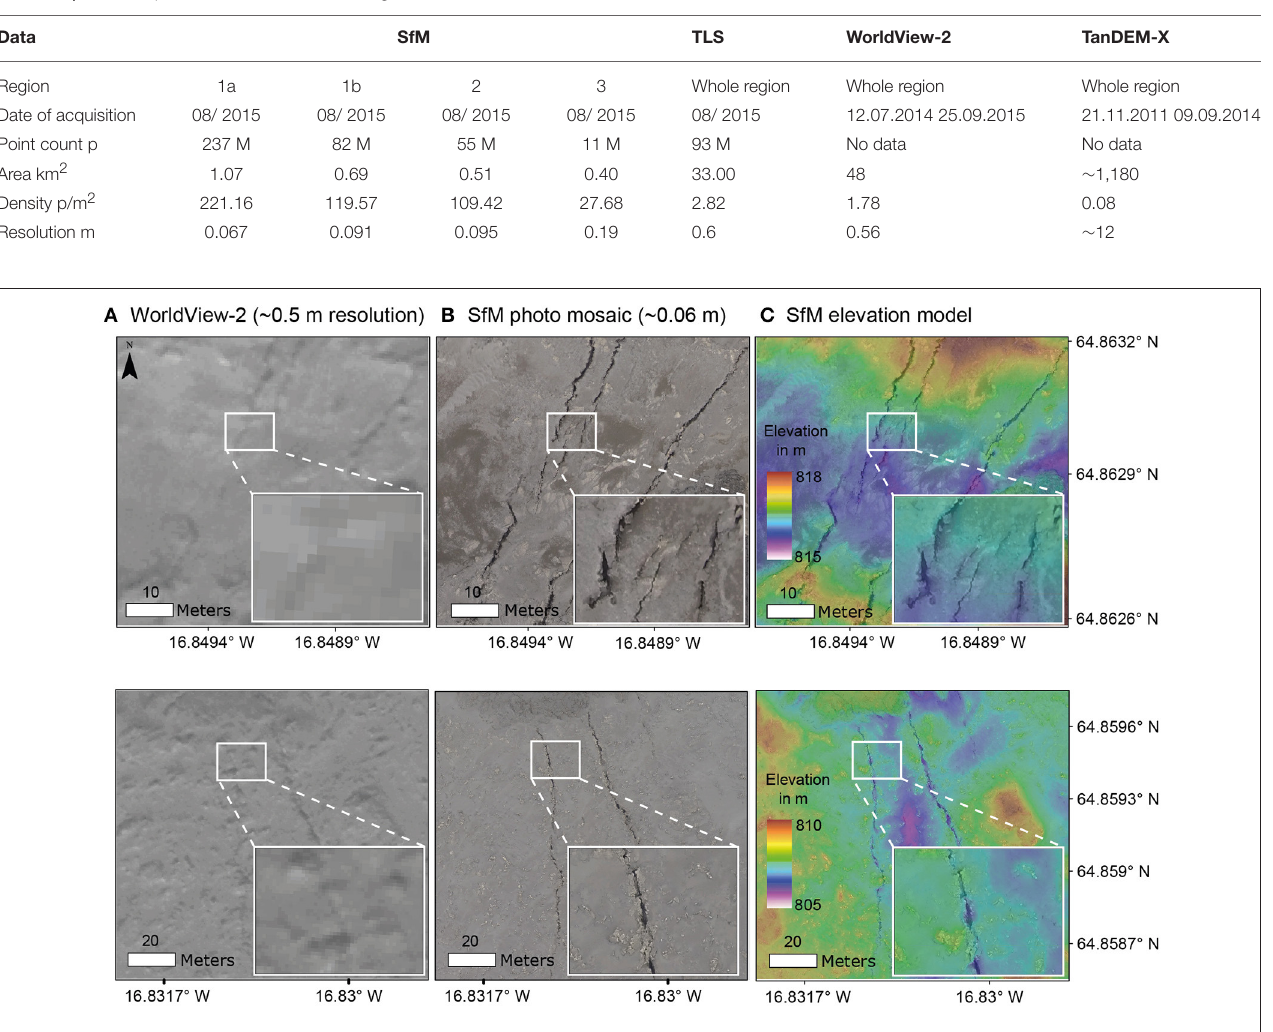
FIGURE 3 | Resolution– (A) WorldView-2 panchromatic data with a spatial resolution of ∼ 0.6m, (B) UAV-based SfM photo mosaic with a resolution of 0.067m, and (C) UAV-based photo mosaic draped over the DEM obtained from SfM. Locations are inside areas a1 and a2 in Figure 4B . The upper row (area a1) shows the fracturing close to the 2014 Holuhraun eruption site at the western graben fault; the lower row (area a2) shows the fracturing at the eastern graben